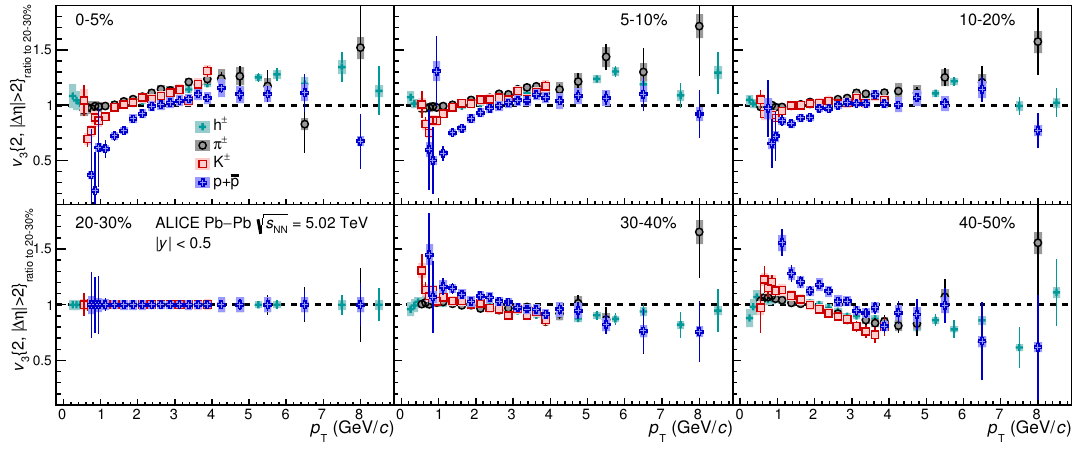
Figure 16 . (Colour online) Centrality dependence of v 3 ( p T ) inclusive charged particles [44]. Statistical and systematic uncertainties are shown as bars and boxes,